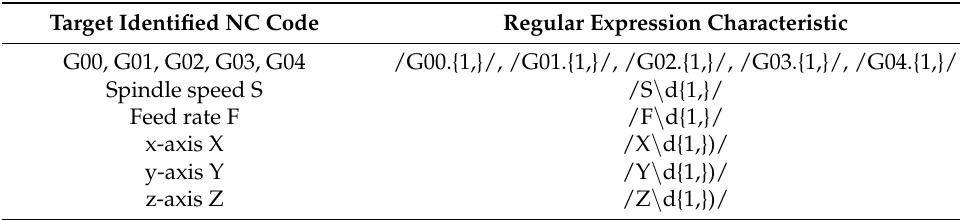
Table 1. Regular Expression characteristics.